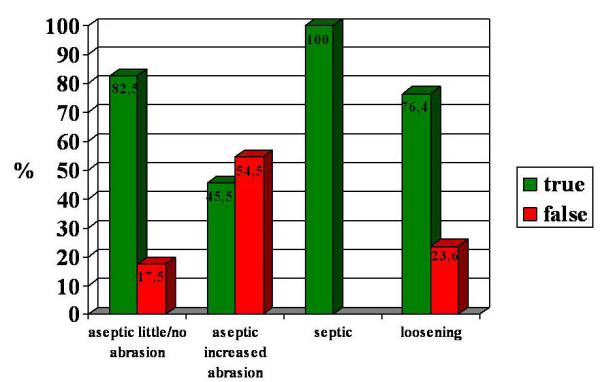
PET findings with reference to mechanical prosthetic loosening and inflammation.